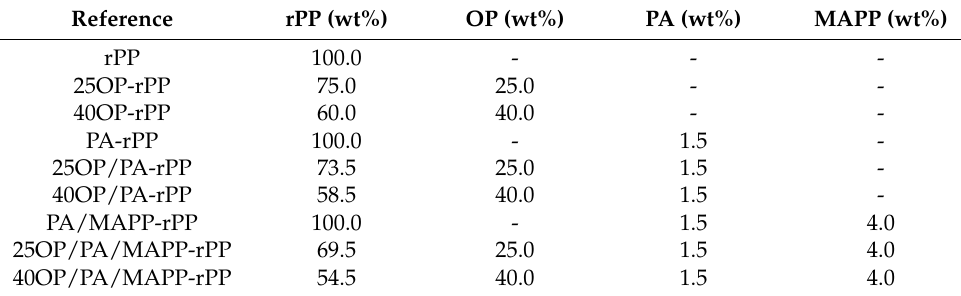
Table 1. Composition of the different composites